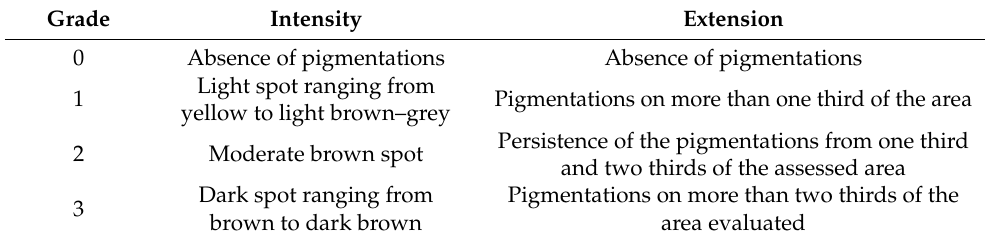
Table 1. Modified Lobene Index.